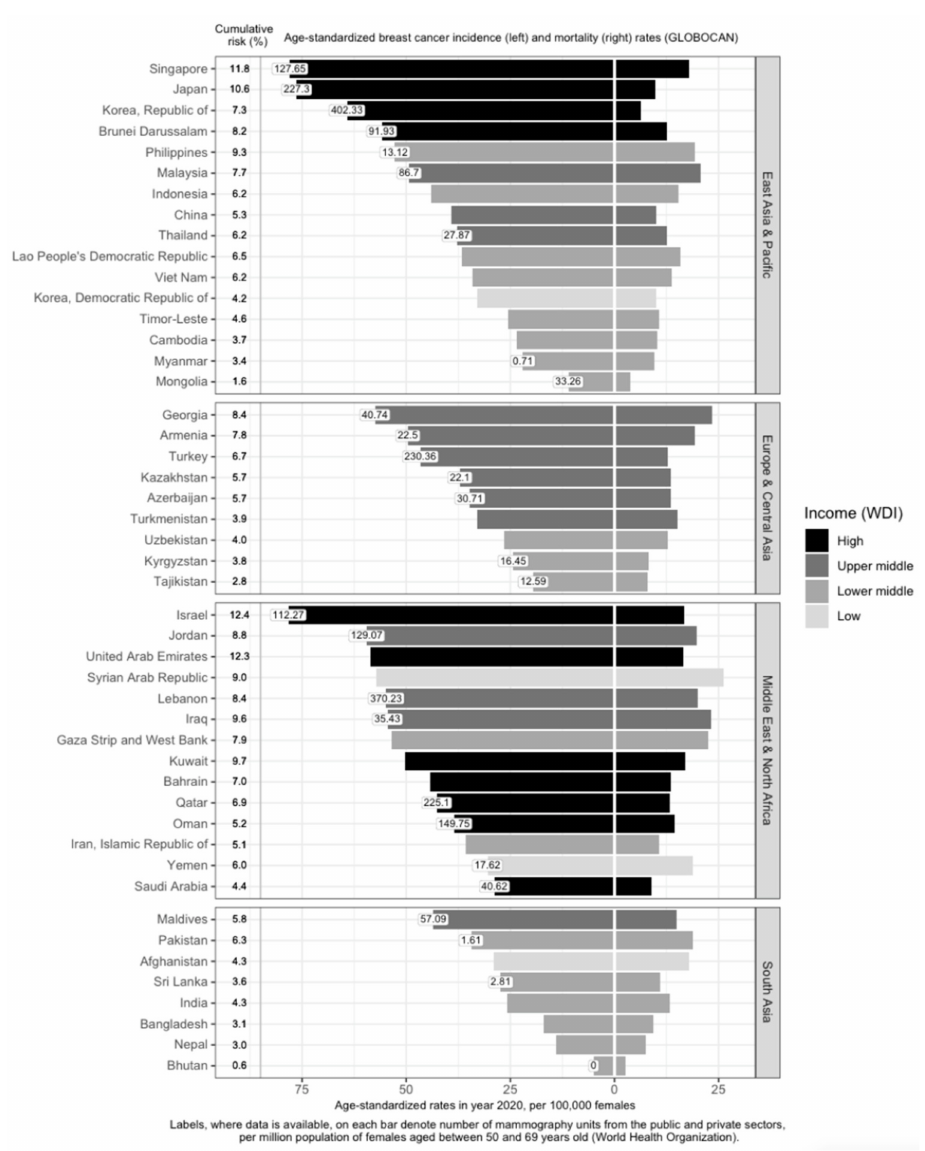
Figure 1. Variation of breast cancer burden and availability of breast cancer screening resources (mammography units) in Asia by region, country and income level. Age-standardized incidence rate (ASIR) of breast cancer, age-standardized mortality rate (ASMR) of breast cancer, income group, cumulative risk up to 74 years (%), and number of mammography units per 1 million females aged 50 to 69 years in Asia. GLOBOCAN and income statistics from year 2020. Information on mammography units per million female residents retrieved from World Health Organization (2022). Missing labels denote mammography resource information not available for the respective country. WDI: World Development